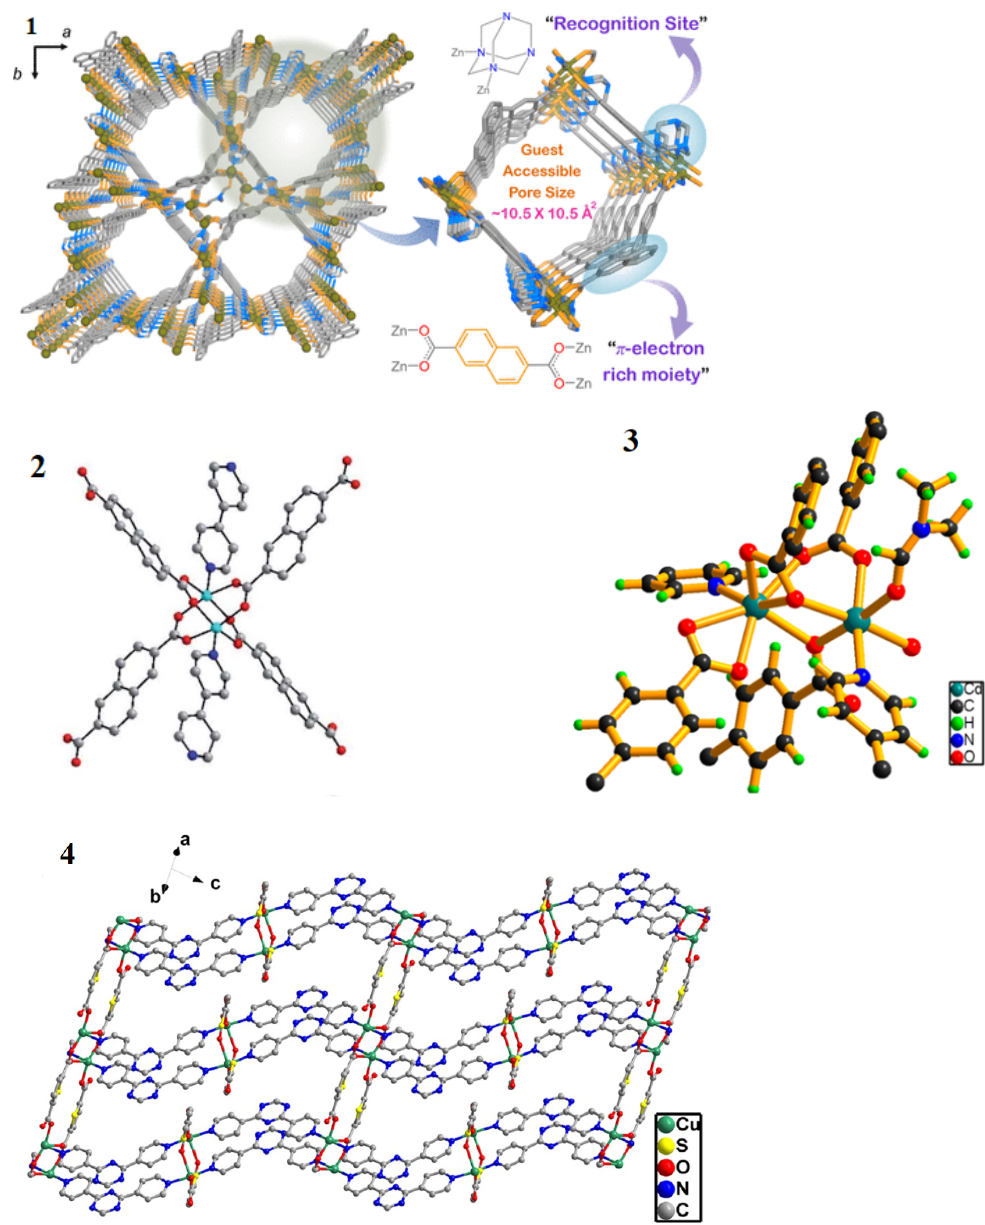
Figure 2. Structures of selected Zn-MOF compounds: ( 1 ) [Zn 4 (DMF)(Ur) 2 (NDC) 4 ] (a) Perspective view of the three-dimensional porous framework along the crystallographic c axis; (b) Perspective view of each of the single one-dimensional channel decorated with fluorescent π -electron rich naph- thalene. Reprinted with permission from [60]. Copyright 2015, American Chemical Society; ( 2 ) Per- spective view of the secondary building unit in the structure of [Zn 2 (NDC) 2 (bpy)] · Gx. Reprinted with permission of the Royal Society of Chemistry from [61]. Copyright 2014, permission conveyed through Copyright Clearance Center, Inc.; ( 3 ) Perspective view of secondary building unit of ([Cd 4 ([1,1 (cid:48) :3 (cid:48) ,1 (cid:48)(cid:48) - terphenyl]-4,4 (cid:48) ,4 (cid:48)(cid:48) ,6 (cid:48) -tetracarboxyl) 2 (2-amino-4,4 (cid:48) -bipyridin) 3 (H 2 O) 2 ] · 8DMF · 8H 2 O). Reprinted with permission from [62]. Copyright 2016, American Chemical Society.; ( 4 ) 3D network with rectangular tunnels of [Cu 2 (tpt) 2 (tda) 2 ] · H 2 O. Reprinted with permission of Elsevier from